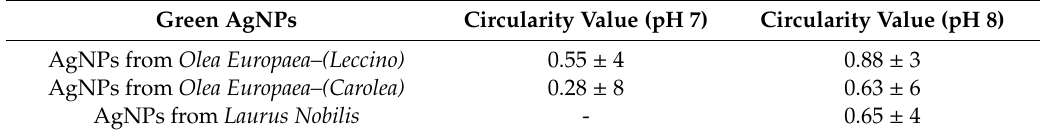
Table 2. Circularity values obtained using ImageJ software on TEM